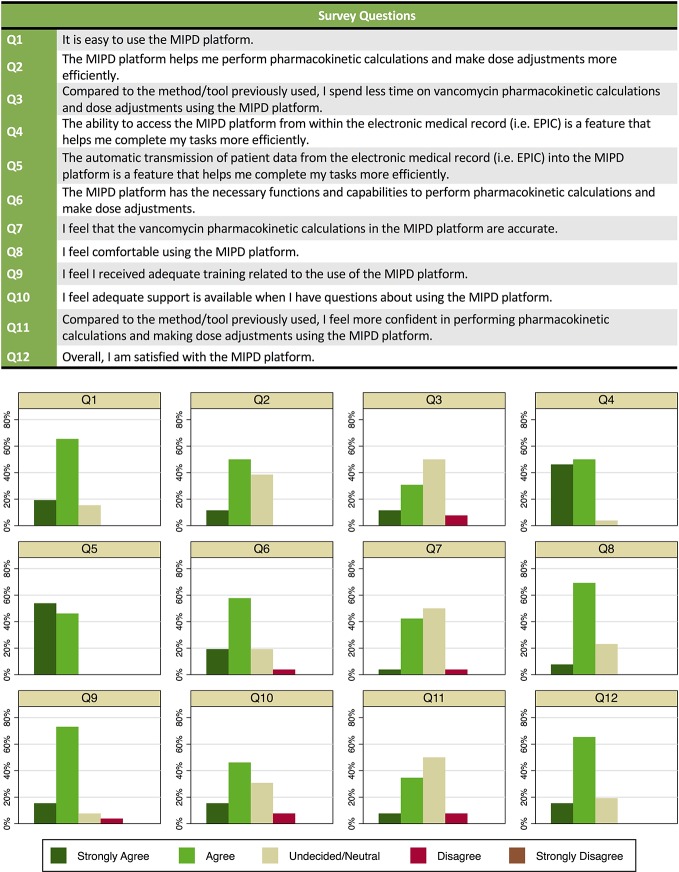
Survey questions and responses of clinical pharmacists (n = 26) on use of and experience with the model-informed precision dosing clinical decision support (CDS) tool in clinical care.